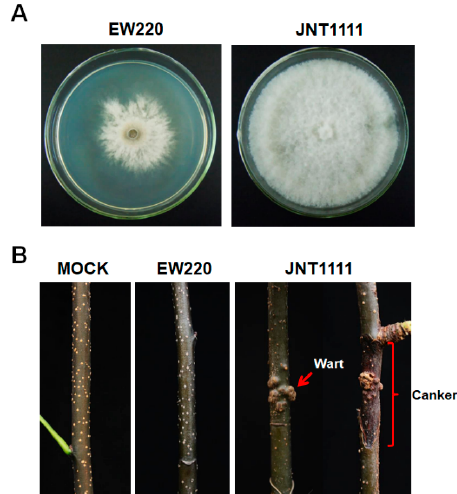
Figure 1. Colony morphology and virulence of strains EW220 and JNT1111 on pear shoots ( P. pyrifolia cv ‘Hohsui’). ( A ) Colony morphology in potato dextrose agar (PDA) medium (28 °C, 4 days); ( B ) pear shoots unwound-inoculated with colonized plugs of the tested strains photographed at 60